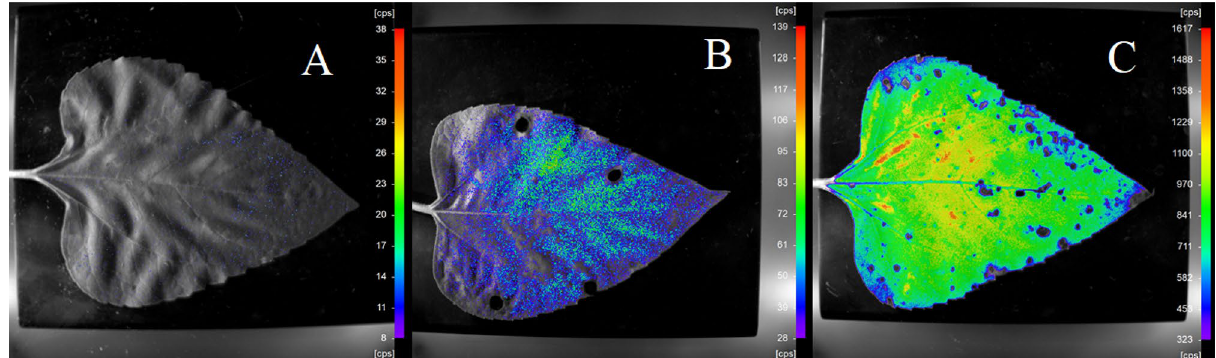
Figure 1. Representative 2 D-overlay images of black and white photos acquired by using the NightOWLcam ultra-sensitive CCD-camera (Berthold Technologies, Germany) mounted onto a dark, light-tight chamber of the NightShade LB 985 instrument and the pseudo colours-coded pixel intensity values visualising the spatial distribution and intensity of UPE (ultra-weak photon emission) on a leaf of a sample Helianthus annuus plant grown under ideal conditions and incubated in the dark chamber for 10 min prior to taking the image ( A ); on a leaf of a pierced (for mimicking herbivory attack) H. annuus plant ( B ) and on one of the leaves of a sunflower plant exposed to drought ( C ). The intensity colour bars on the right side of the images show signal intensities of pixels detected by the CCD-sensor and converted into colour-codes via the analysis software, according the scale